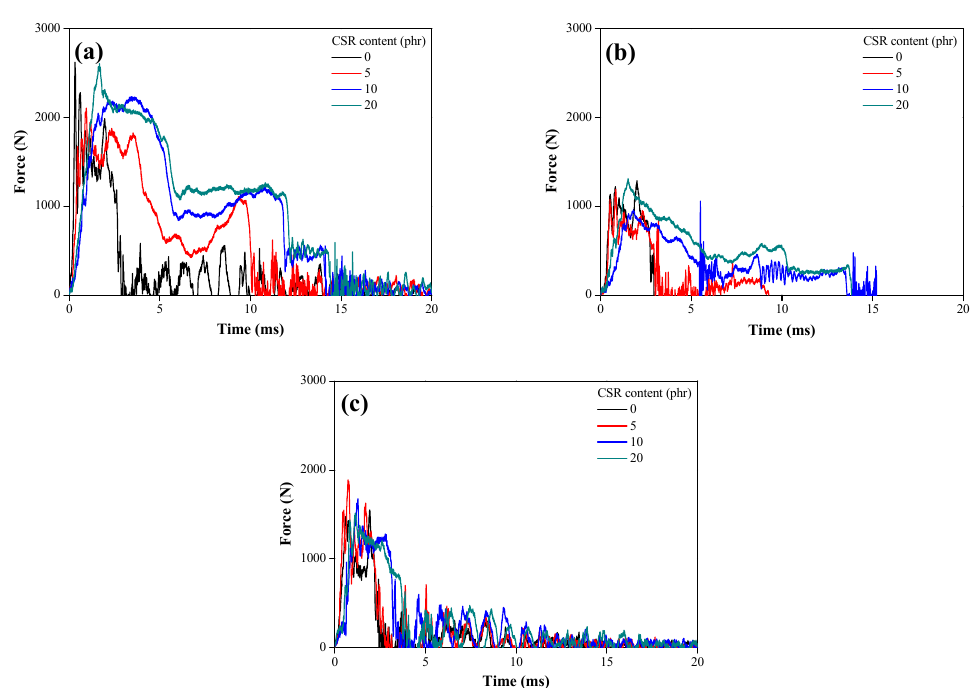
Figure 7. Time–force curves of impact wedge–peel test: Foaming agent content of ( a ) 0 phr, ( b ) 0.1 phr, and ( c ) 1 phr. Table 3. Type of crack growth and displacement for cleavage of CSR/epoxy composite foam adhesives. Foaming Agent Content (phr)